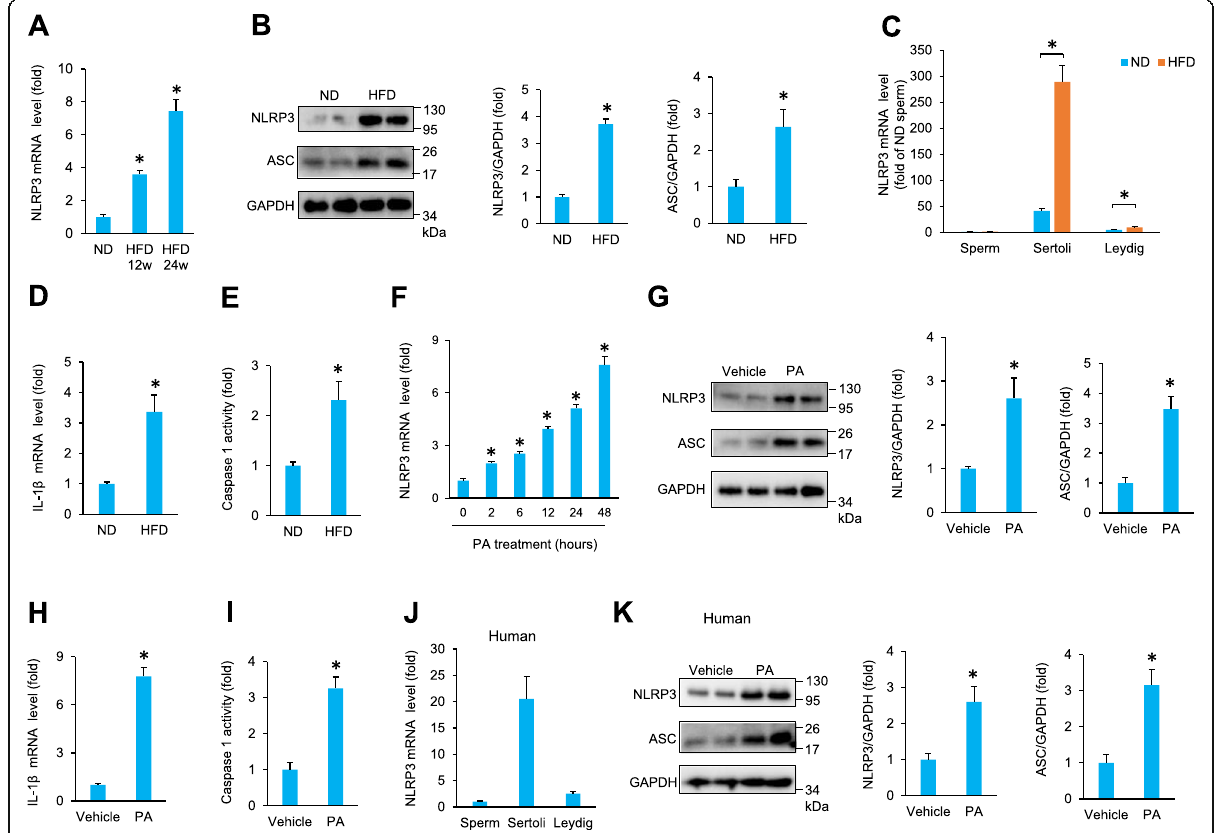
Fig. 1 NLRP3 expression is upregulated by obesity. A The mRNA levels of NLRP3 in the testes of obese mice ( n = 6). B Western blot analysis and quantitative results of NLRP3 and ASC in the testes of obese mice ( n = 6). (C) NLRP3 mRNA levels in cell populations isolated from the testes of obese mice ( n = 6). D The mRNA level of IL-1 β in primary SCs isolated from HFD mice ( n = 6). E Caspase 1 activity in primary SCs isolated from HFD mice ( n = 6). F The mRNA levels of NLRP3 in primary SCs ( n = 6). G Western blot analysis and quantitative results of NLRP3 and ASC in primary SCs ( n = 6). H , I The mRNA levels of IL-1 β and caspase 1 activity in primary SCs ( n = 6). J NLRP3 mRNA levels in cell populations isolated from the human testis ( n = 5). K Western blot analysis and quantitative results of NLRP3 and ASC in human primary SCs ( n = 5). Data are presented as the mean ± SD. For A and F , the statistical analysis was carried out by Student ’ s two-tailed t test; for others, the statistical analysis was carried out by one-way ANOVA. * P < 0.05 vs the matched